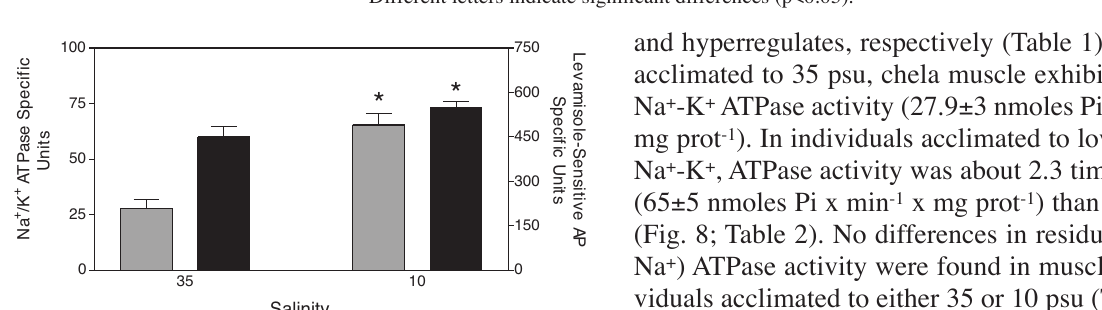
f ig . 7. – effect of temperature (4-45ºC) on levamisole-sensitive aP activity at pH 7.4 in chela muscle of C. angulatus . the values of aP activ- ity are expressed as a relation to the corresponding activity at 37ºC (100%, 464.3±61.4 and 1186.6±199.7 nmoles pnP x min -1 x mg prot -1 at